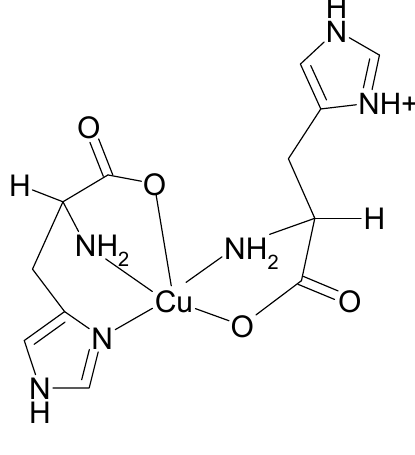
complex at physiological pH. 2